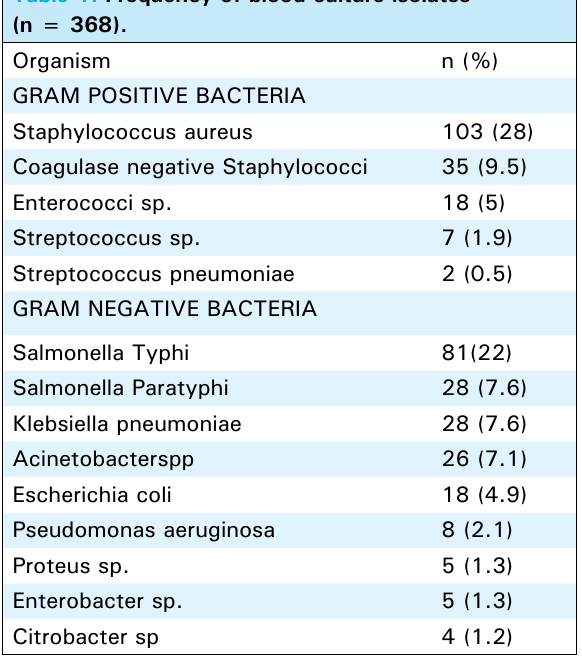
table 1. Frequency of blood culture isolates (n =